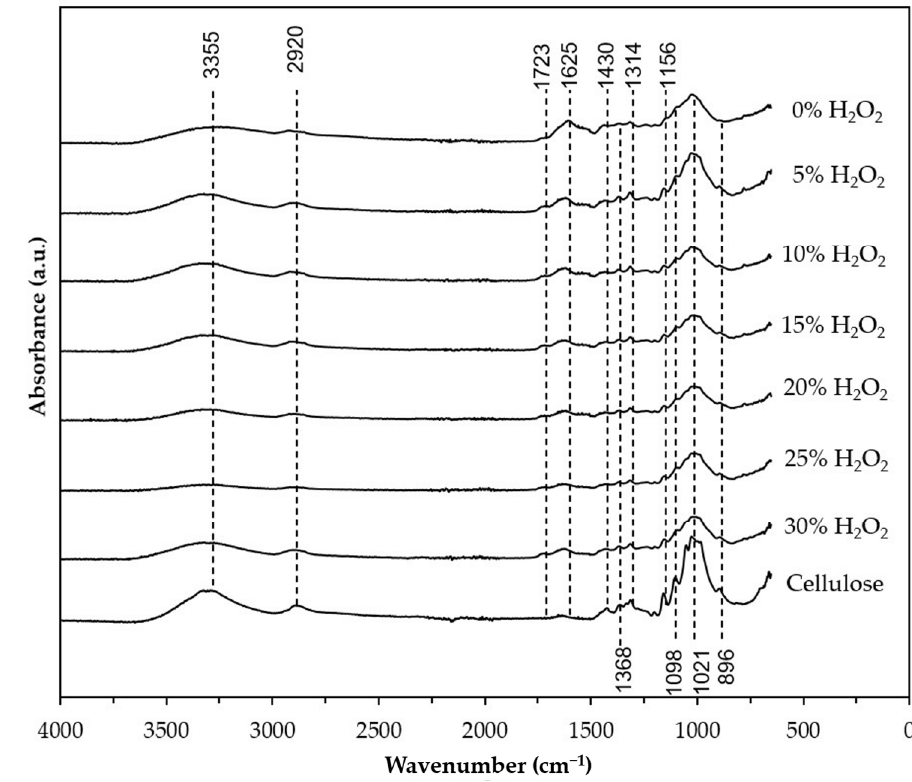
Figure 4. FTIR spectra of the banana peel after pre ‐ treatment using different H 2 O 2 concentration (5%, 10%, 15%, 20%, 25%, and 30%). Untreated banana peel (0% H 2 O 2 ) was used as a control. The pre ‐ treatment was conducted at 90 °C for 2 h.